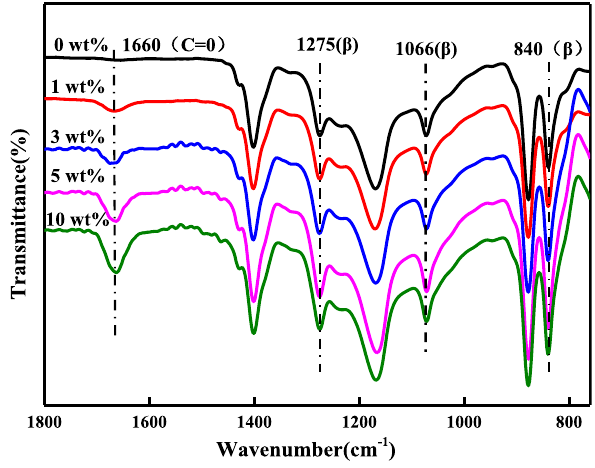
Fig.9 FTIR spectra of PVDF membranes produced with different PVP concentrations